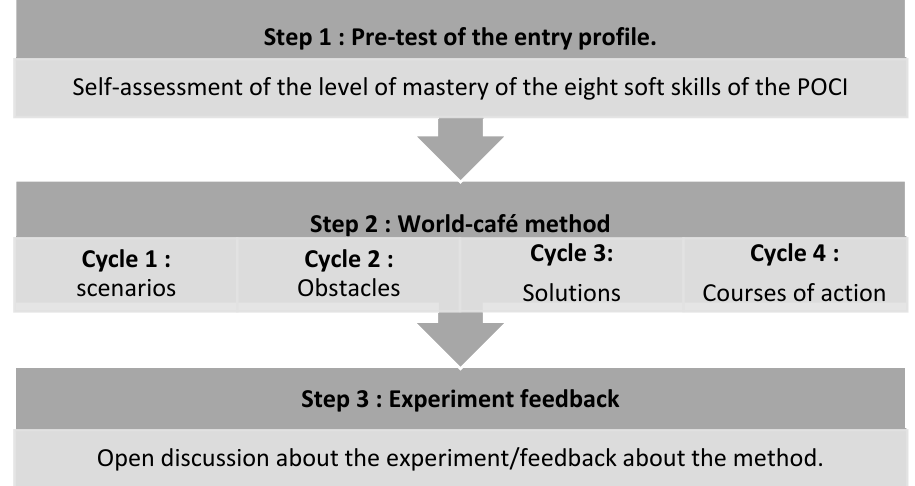
Step 3 : Experiment feedback Open discussion about the experiment/feedback about the method. Figure 1. The three main steps of the World Café protocol. Figure 1. The three main steps of the World Caf é